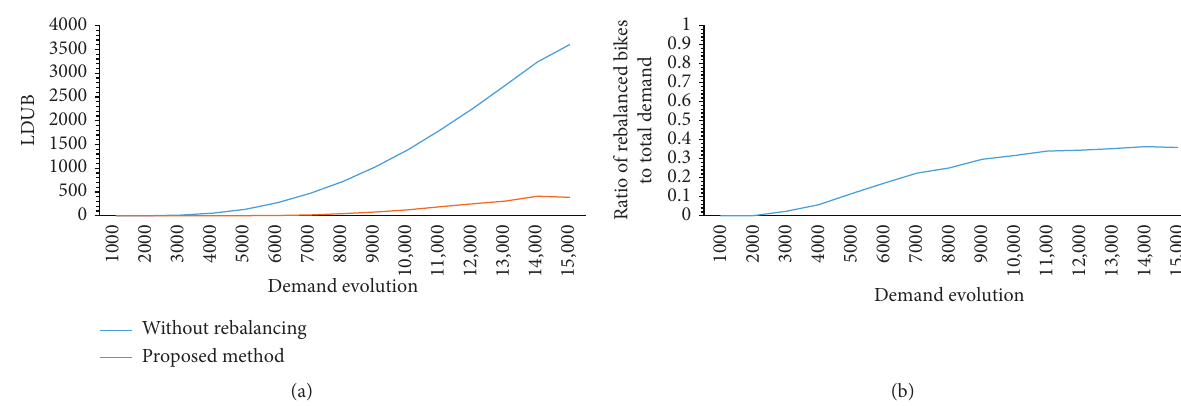
Figure 5: (a) LDUB evaluation as a function of demand evolution; (b) ratio of rebalanced bicycles to total demand.